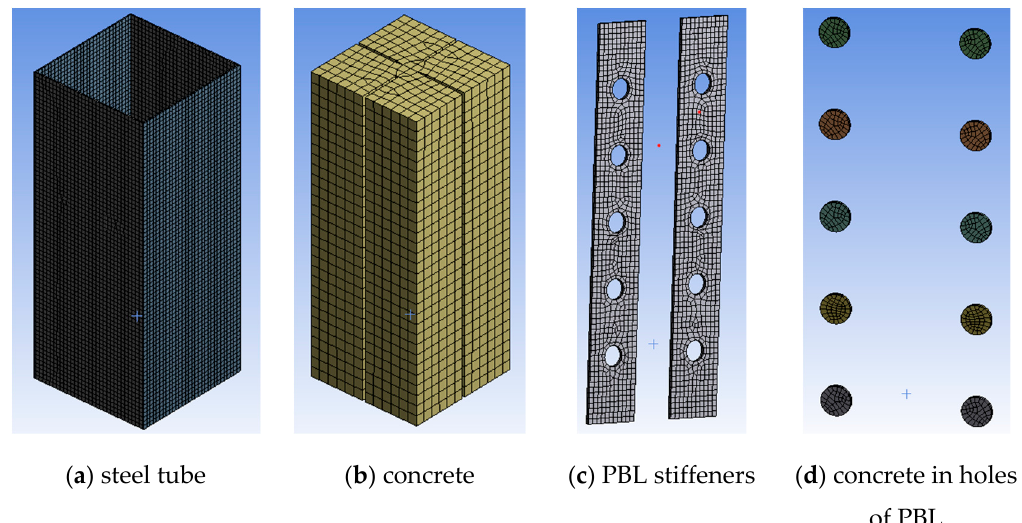
Figure 7. Mesh generation of finite element model.